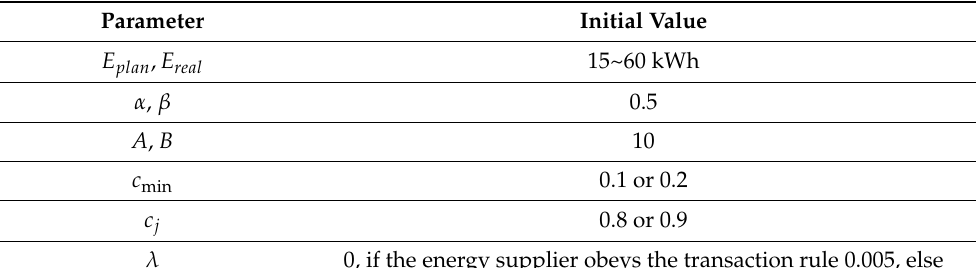
Table 1. The initial values of the